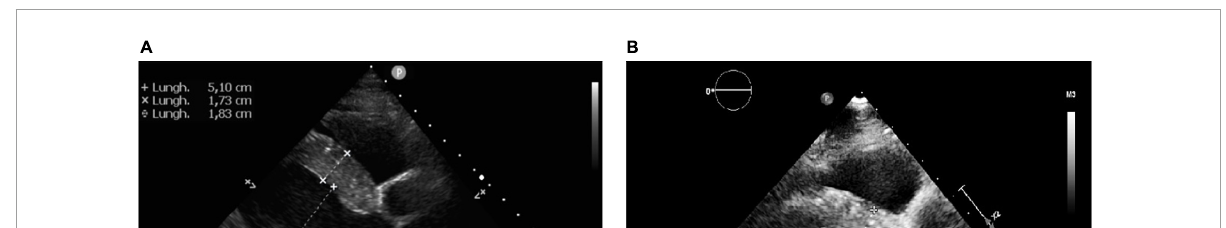
FIGURE4 ECG at follow-up visit 4 months after discharge.